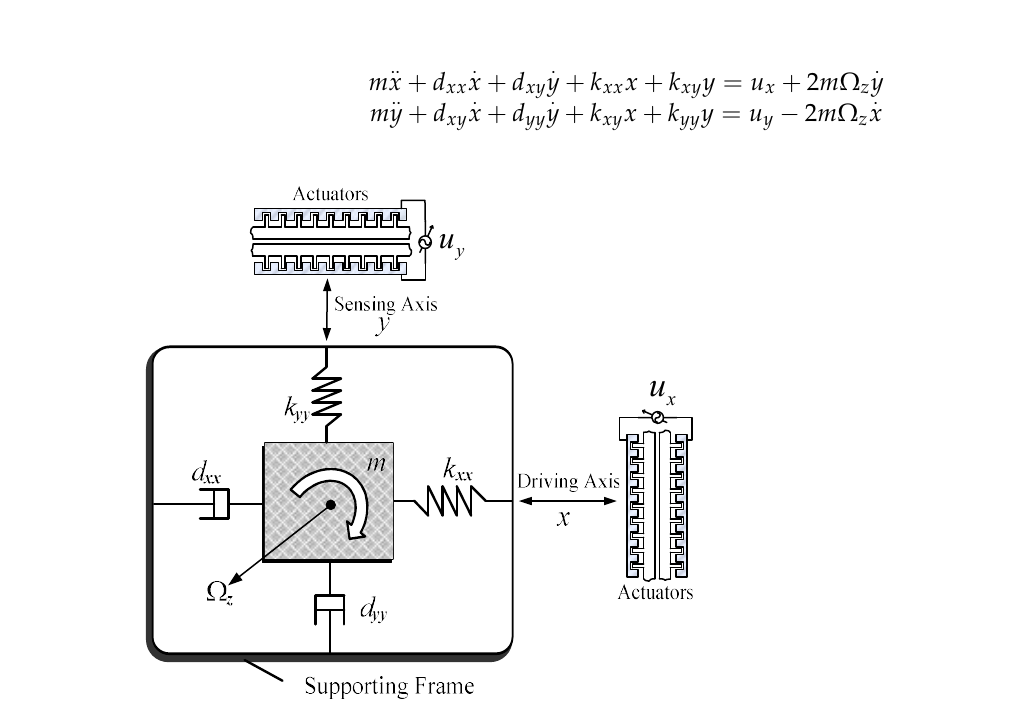
Figure 1. Schematic diagram of a microelectro mechanical system (MEMS) gyroscope in the x-y plane. Fabrication imperfections result in the asymmetric spring and damping terms, k xy and d xy . The spring and damping terms, k xx , k yy , d xx , and d yy in the x and y axes are mostly known, but have small unknown variations from their nominal values. The proof mass can be determined very accurately, and u x , u y are the electrostatic forces in the x and y